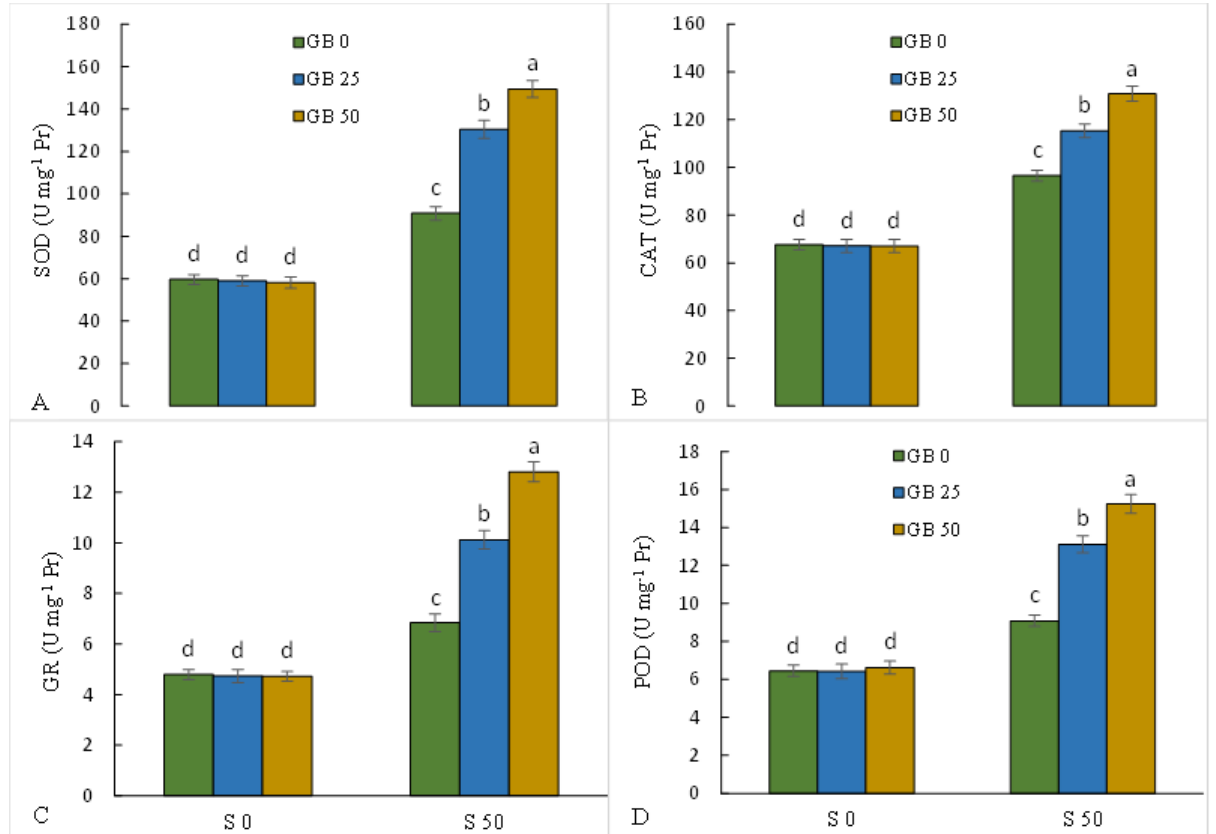
Figure 4. Effect of glycine betaine (GB, 0, and 50 mM) on the activity of antioxidant enzymes (superoxide dismutase (SOD, ( A )), catalase (CAT, ( B )), glutathione reductase (GR, ( C )), and peroxidase (POD, ( D ))) in stevia leaves under NaCl (0, 25, and 50 mM) treatment. Values (means ± SD, n = 6) followed by the same letter are not significantly different ( p < 0.05; Duncan test).